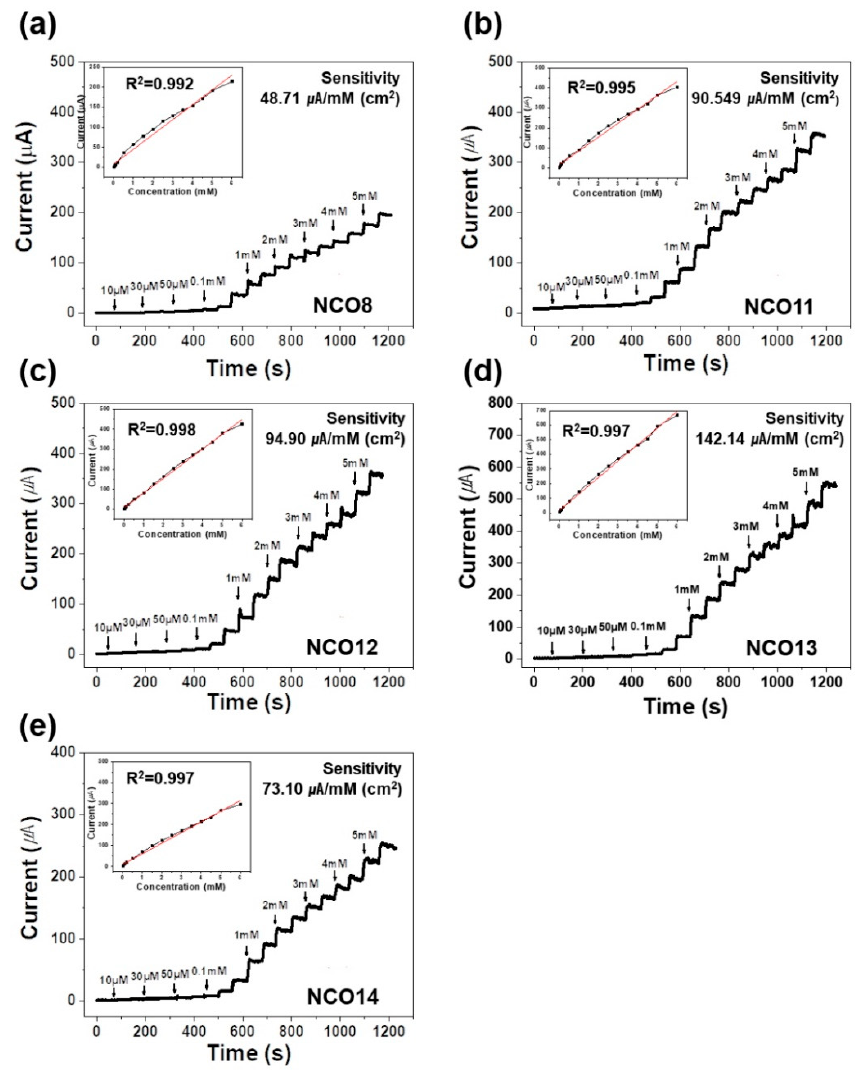
Figure 4. CA responses of ( a ) NCO8, ( b ) NCO11, ( c ) NCO12, ( d ) NCO13, and ( e ) NCO14 electrodes with the addition of glucose to 0.1 M NaOH solution at 0.50 V. Their respective calibration curves of current response versus glucose concentration plots inset in the figure.